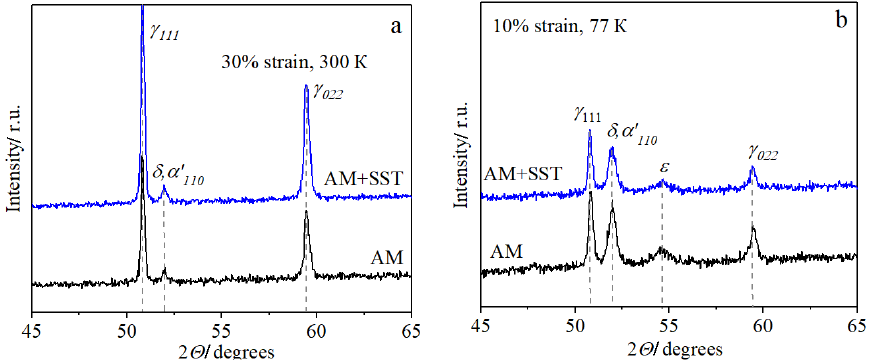
Figure 5. X-ray diffraction patterns for the AM, AM + SST samples tensile-tested with 30% strain ( a ) and 10% strain ( b ) at room temperature ( a ) and at 77 K ( b ). Table 1. The characteristics of the stage II of the plastic flow for the AM, AM + SST and the as-cast samples.